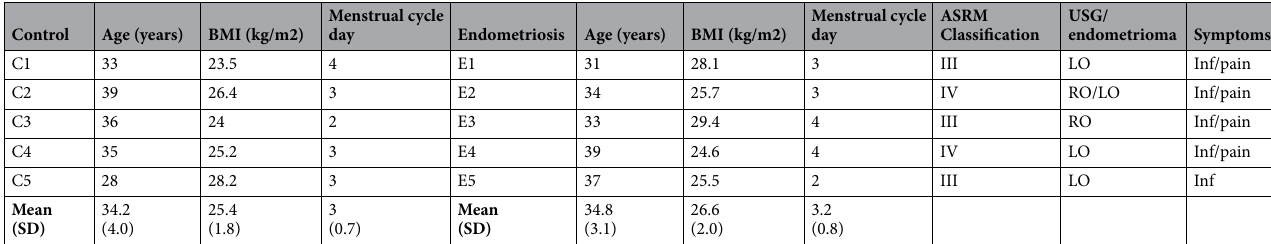
Table 2. Characteristics and clinical data of patients with and without endometriosis. BMI body mass index; USG ultrasonography; LO left ovary; RO right ovary; Inf